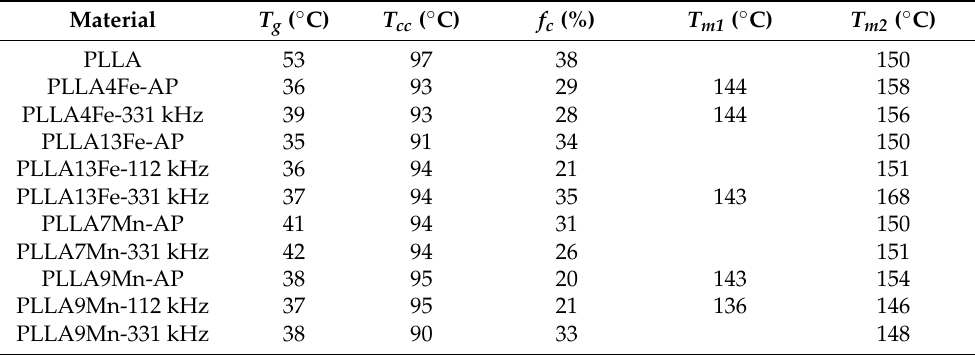
Table 4. Glass transition temperature, T g ( ± 1 ◦ C), cold crystallization temperature, T cc ( ± 1 ◦ C), crystalline fraction, f c ( ± 4%), and melting temperatures, T m1 and T m2 ( ± 1 ◦